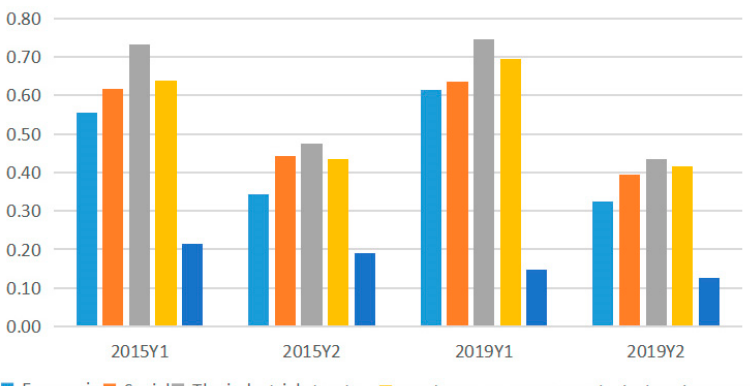
Figure 6. Change of factor influence from 2015 to 2019.